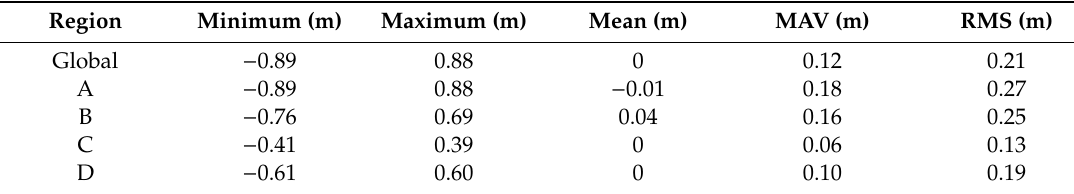
Table 1. Statistics of the comparison of DoD values for four regions of the town.